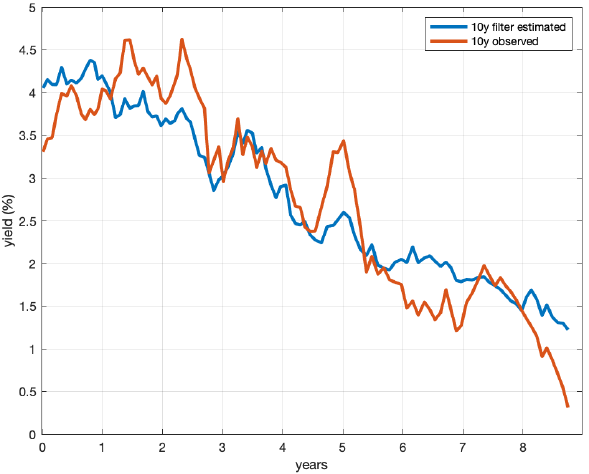
Figure 6. Comparison between the market yield rate (blue line) and the model − implied yield rate (red line) for the 10 − year maturity.